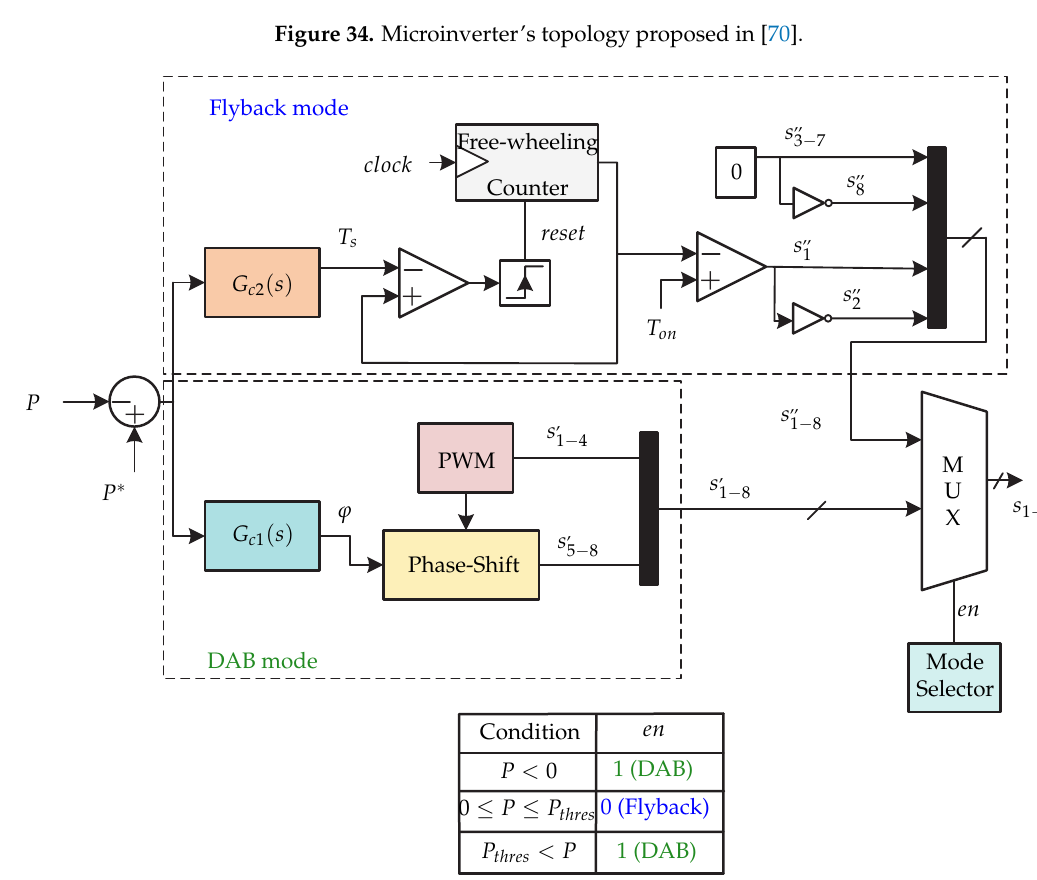
Figure 35. Control strategy proposed in [70].